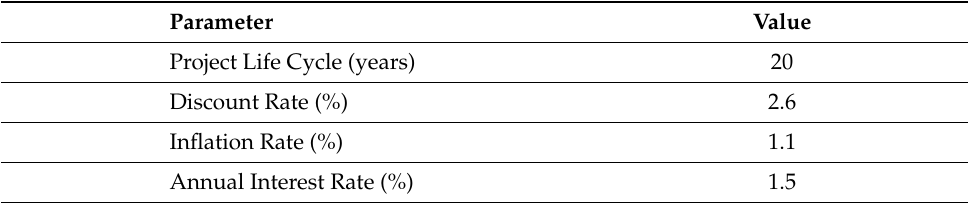
Table 4. Control parameters and project